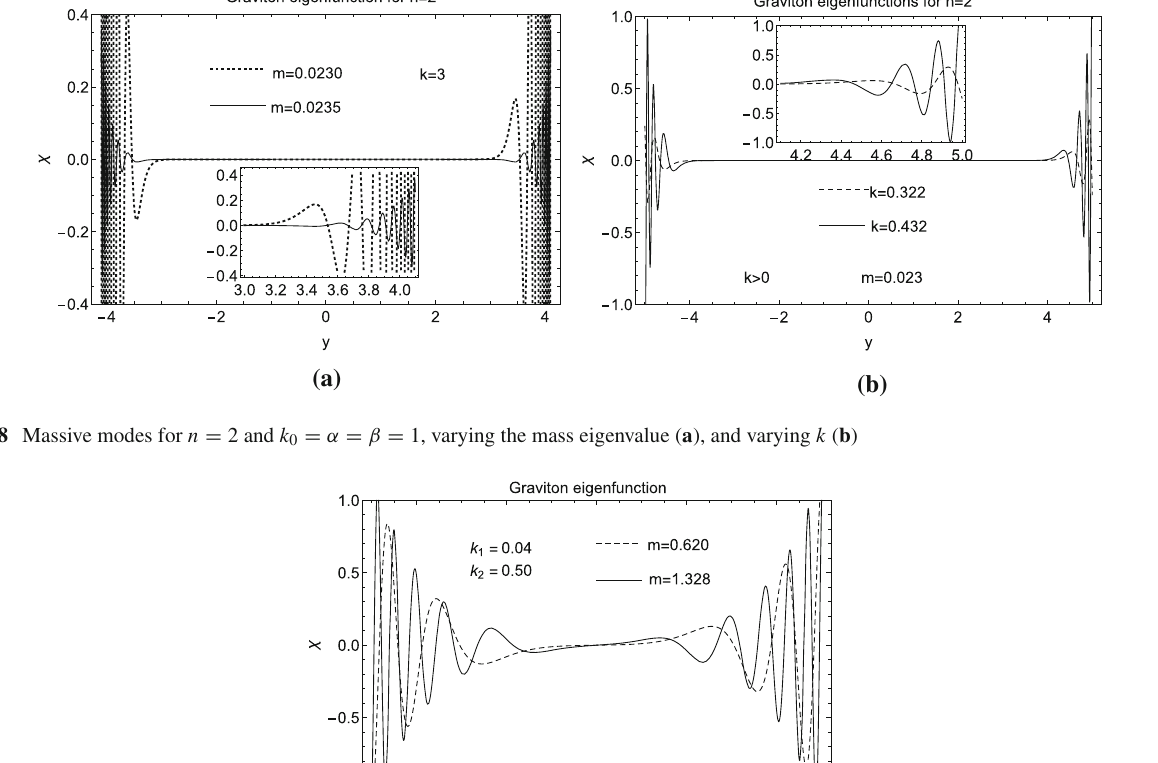
on the brane. Note that, in the limit tending to the TEGR, 3 → N Ψ A .Letusgonowinvestigatethemasslessgravity 2 0 0 e localization